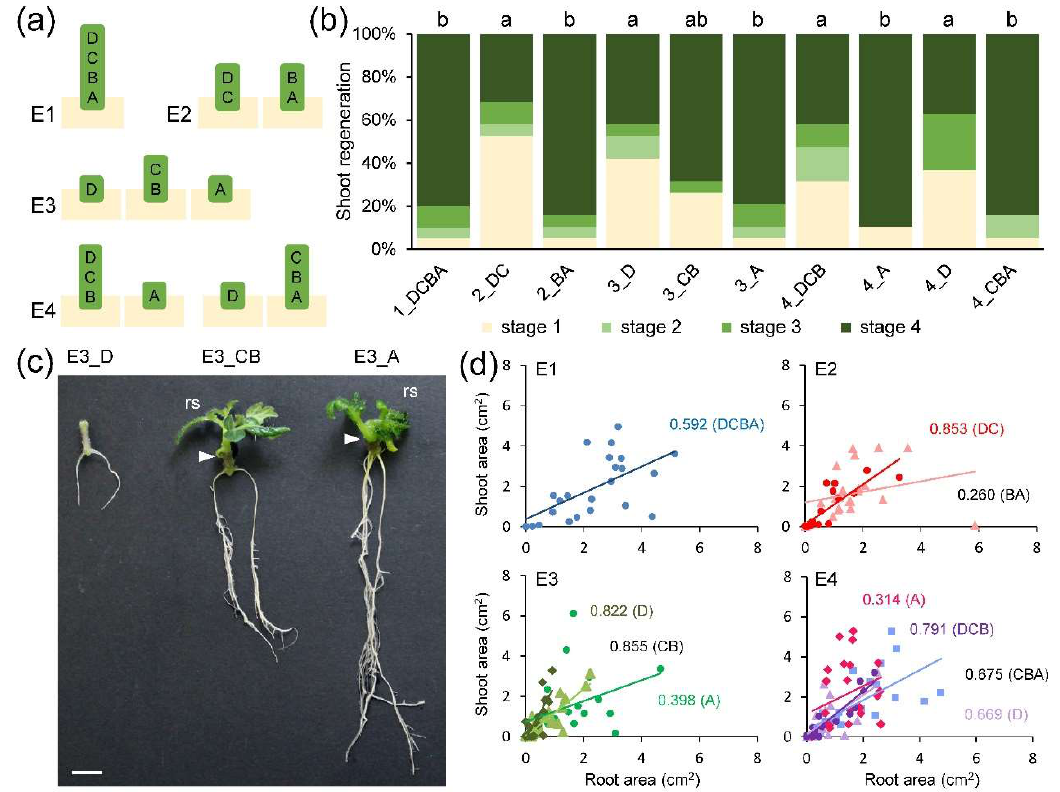
Figure 1. An endogenous developmental gradient regulates de novo shoot formation. ( a ) Diagram showing the hypocotyl fragments used in the different experiments (E1 to E4). ( b ) Shoot regeneration stages of ‘Micro-Tom’ hypocotyl explants at 17 days after excision (dae). ( c ) Representative images of rooted hypocotyl explants at 21 dae. Arrowheads indicate the apical end of the hypocotyl explants at 0 hae; rs: regenerated shoot. ( d ) Relationship between root area and shoot area at 21 dae. Numbers in d indicate Person’s correlation coefficient in the studied samples. Different letters in b indicate significant differences ( p -value < 0.01) between samples. Scale bars in c: 5 mm.